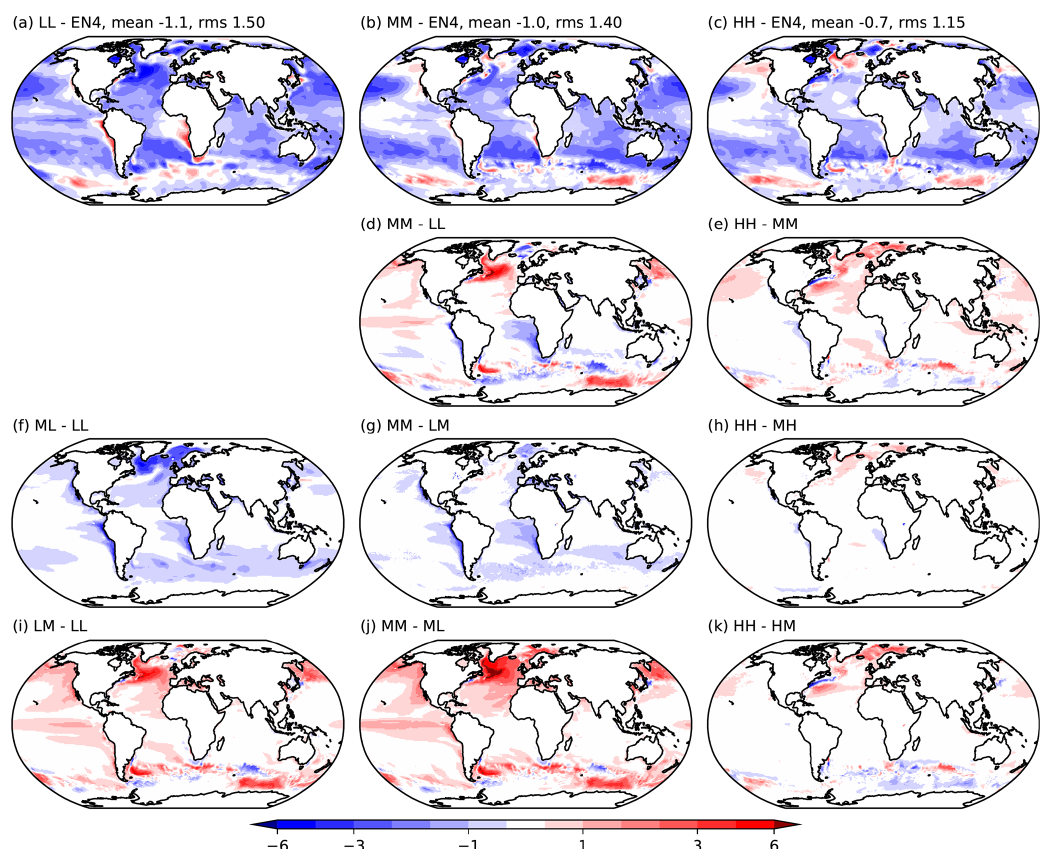
Figure 7. Top row: model SST bias in control-1950 years 50–100 vs. EN4 (1950–1954 mean), with the mean and rms bias shown; second row: the total SST differences between MM-LL and HH-MM resolutions; third row: the impact of changing the atmosphere resolution at each reference ocean resolution; bottom row: the impact of changing the ocean resolution at each reference atmosphere resolution. Units are K. Points that contain annual mean sea ice are